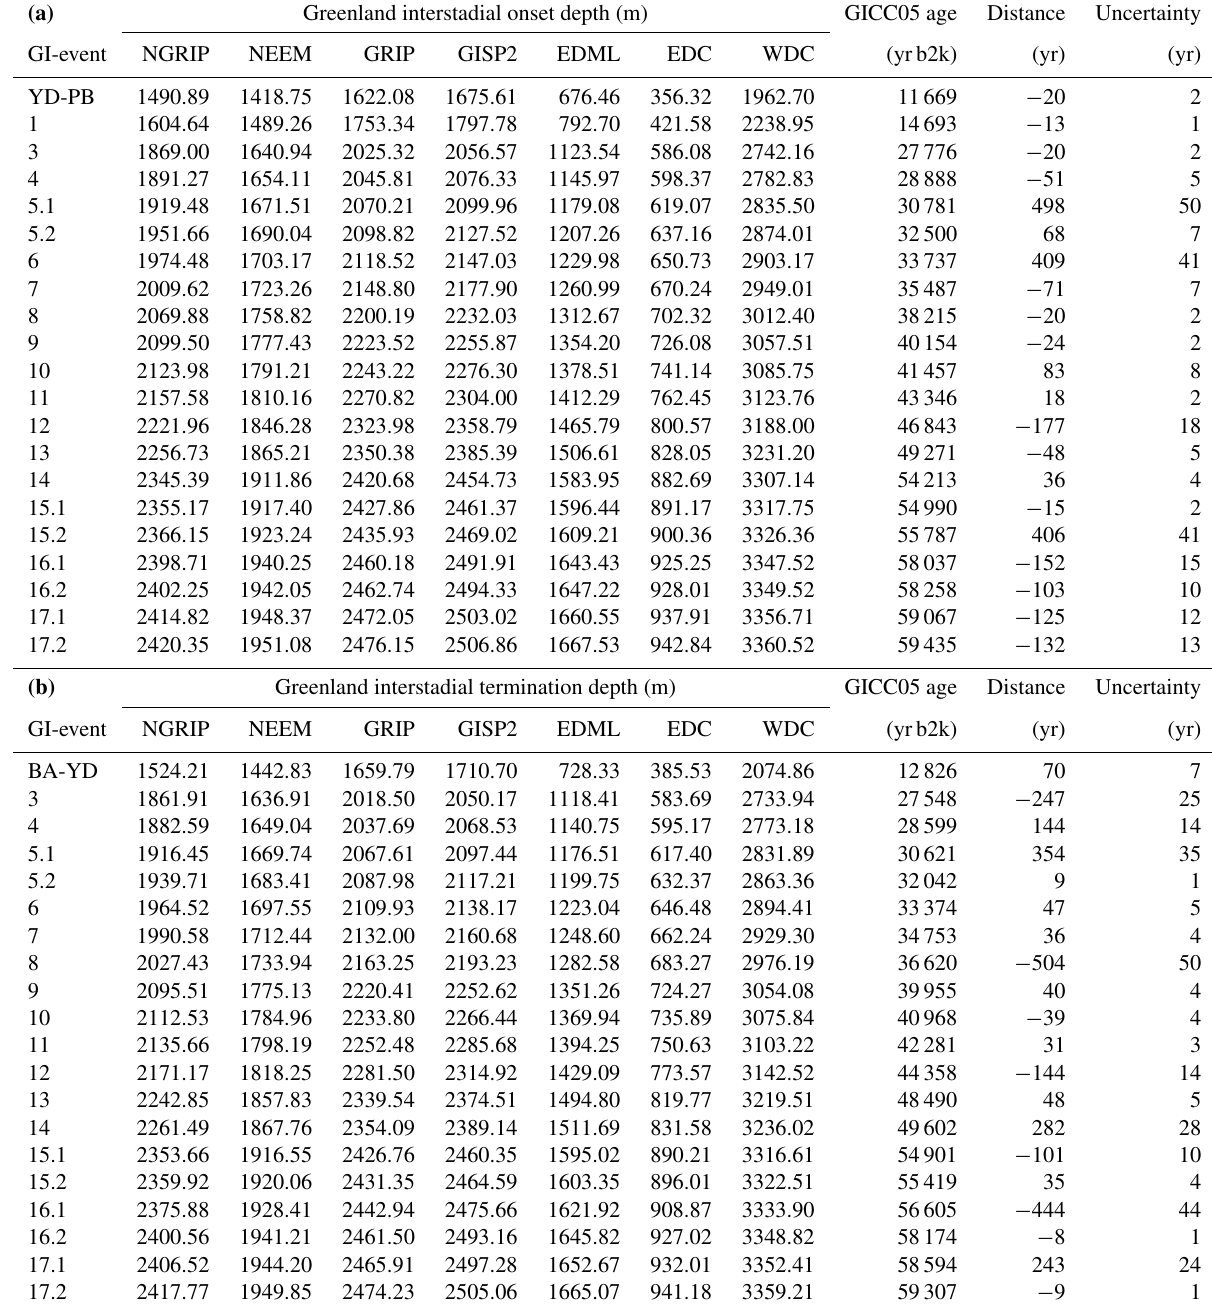
Table 1. Bipolar onsets and terminations. Depths of the Greenland interstadial onsets (a) and terminations (b) in the NGRIP, NEEM, GRIP, GISP2, EDML, EDC, and WDC ice cores based on volcanic matching. The NGRIP onsets are defined as the midpoints of the δ 18 O transitions and are identical to those applied in WAIS Divide Project Members (2015) except for the onset of GI-1. The Greenland match points are from Seierstad et al. (2014), Antarctic match points are from Buizert et al. (2018), and the bipolar match points are from Table S2. Corresponding GICC05 ages are provided with reference to year 2000CE. “Distance” refers to the temporal distance to the nearest bipolar match point in Table S2 with negative values signifying the match point occurring before the onset or termination. The relative uncertainty of the bipolar matching is stated as 10% of the “distance” assuming a 5% maximum counting error of the annual layer counting in both Greenland and Antarctica. “YD-PB” refers to the Younger Dryas–Preboreal transition (the onset of the Holocene) and “BA-YD” refers to the Bølling–Allerød–Younger Dryas transition (the onset of GS-1). All EDC depths are on the EDC99 depth